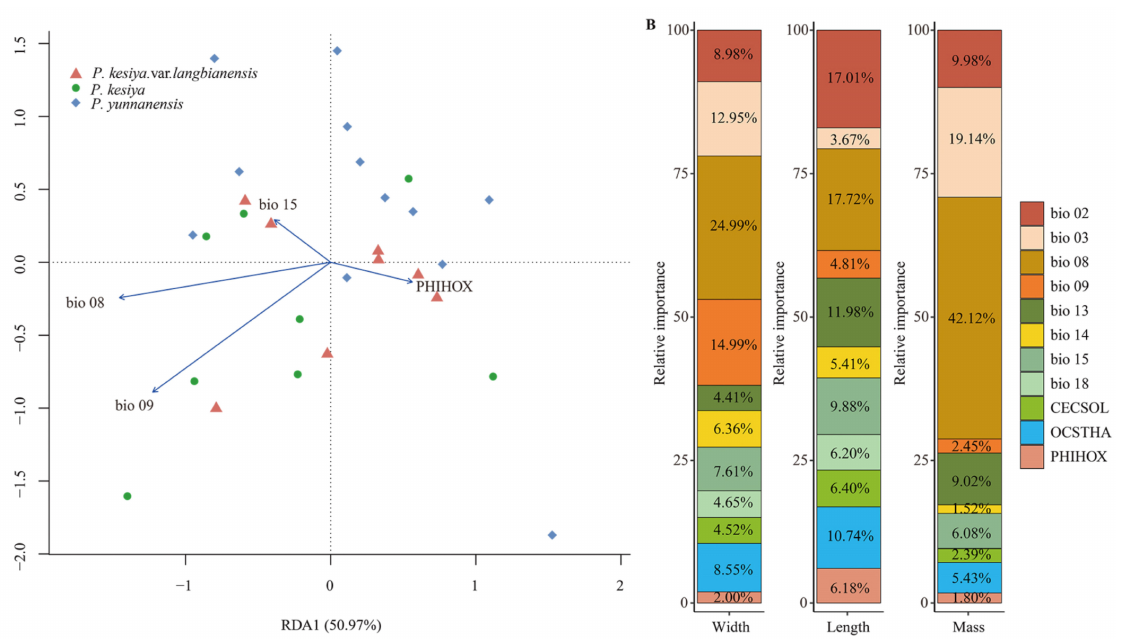
Figure 4. Attempt for revealing the environmental contribution to seed variation among natural populations of the pine complex. ( A ) The redundancy analysis (RDA) based on the seed traits and environmental variables of each location. ( B ) The gradient boosting machine learning (GBM) for the relative importance of each environmental variable on the seed traits. The values of relative influence greater than 0.04 are